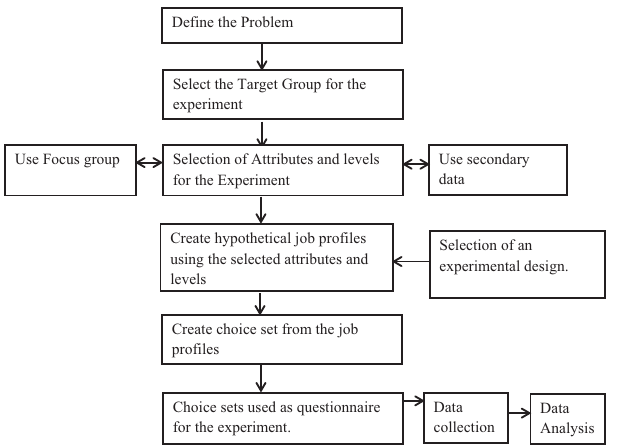
Figure 2. Framework